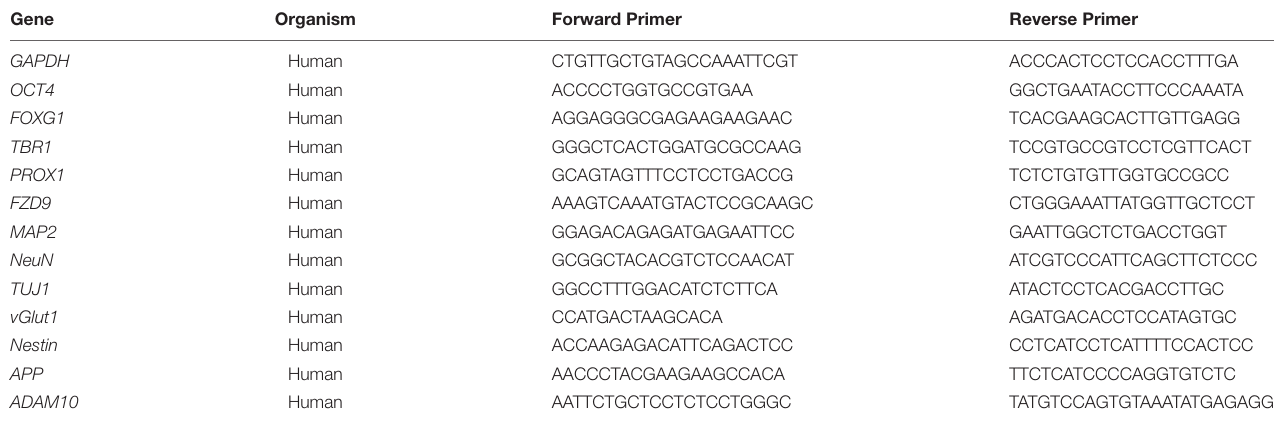
TABLE 1 | List of primers used for quantitative real-time polymerase chain reaction (human). Gene